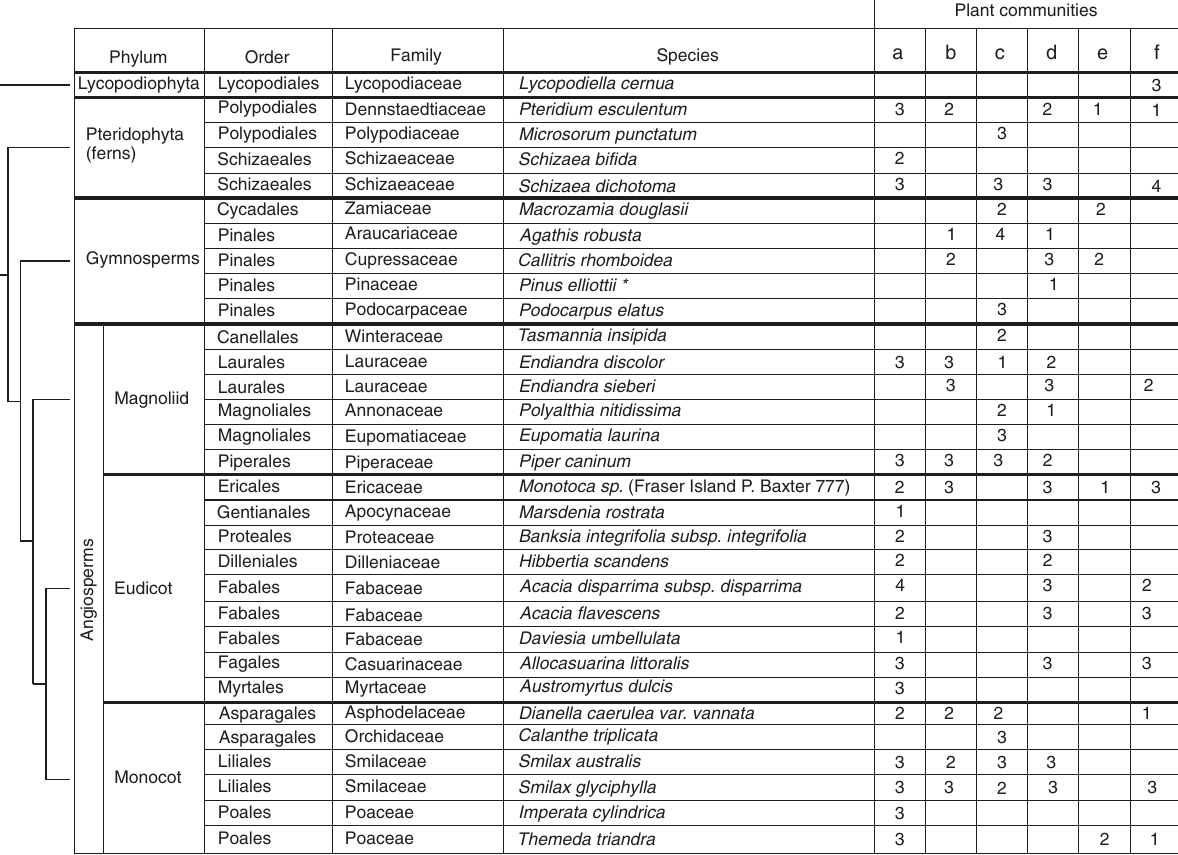
Fig. 2 Plant species and number of root samples for which microbial community pro fi les were successfully obtained. Relationships among the major plant phyla are indicated by a cladogram to the left of the fi